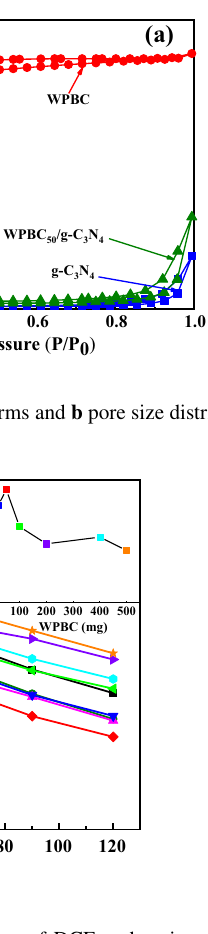
Fig. 4 Kinetics of the photocatalytic degradation of DCF under vis- ible light irradiation in the presence of WPBC/g-C 3 N 4 with dif- ferent WPBC doping amounts (conditions: [DCF] 0 = 0.01 mM, [catalyst] 0 = 0.5 g/L, pH 0 = 5.60 ±